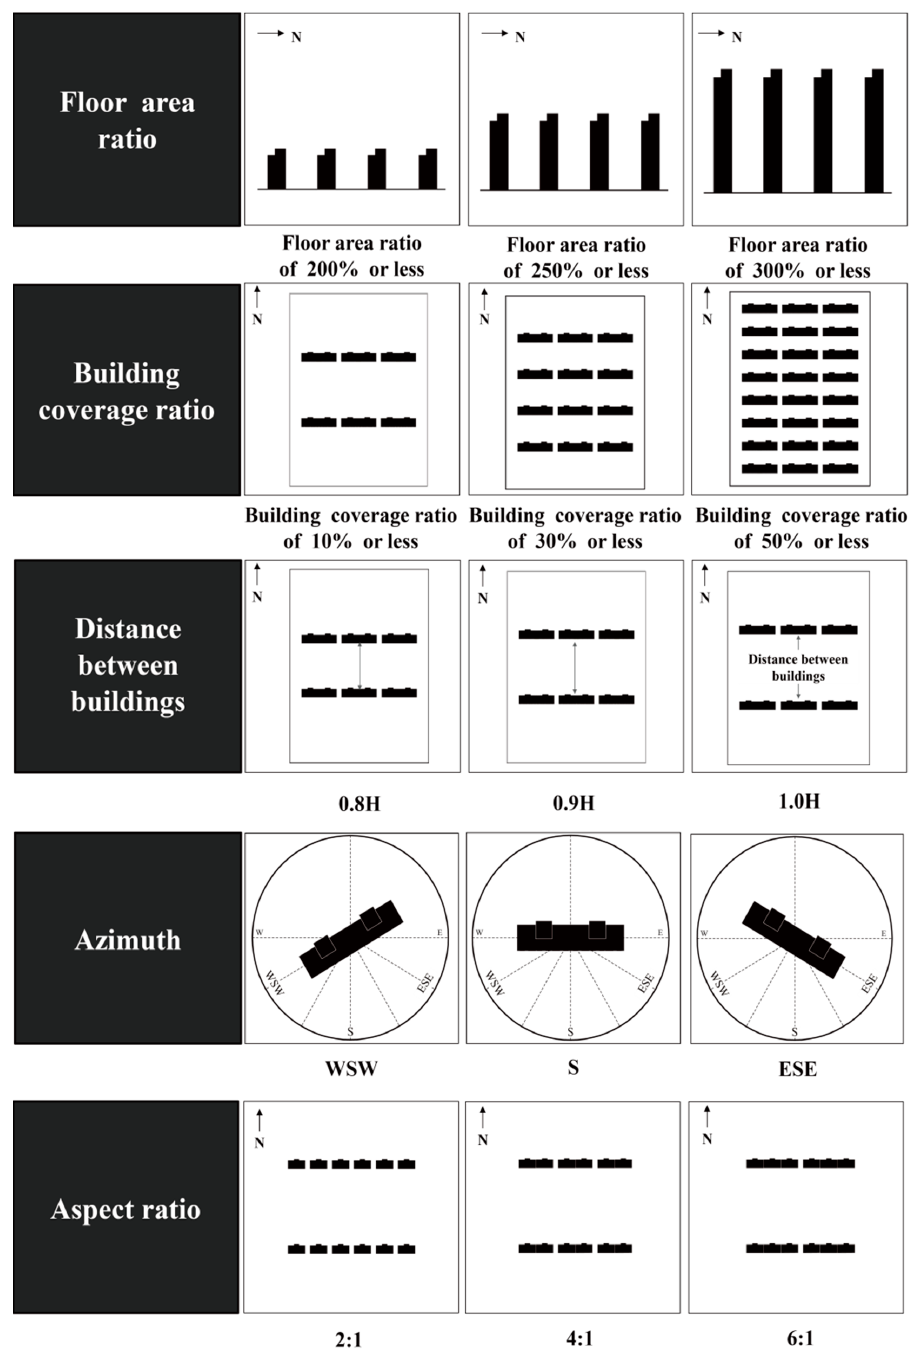
Figure 2. Layout planning design factors.